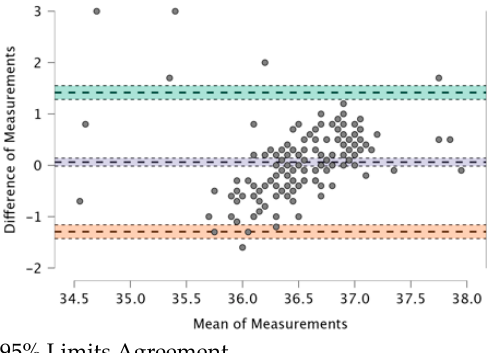
Figure 3. BT–Tympanic Infrared TM and BT–Non-Contact Infrared TM (Forehead).